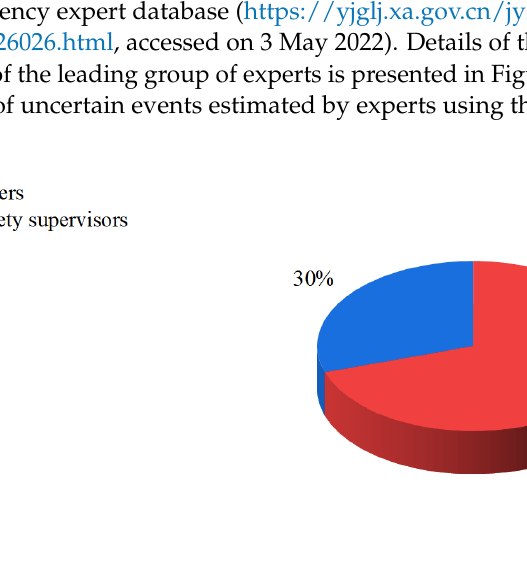
Figure 4. ( a ) The profile of the leading group of experts, ( b ) event distribution. Table 1. Information of a group of experts.